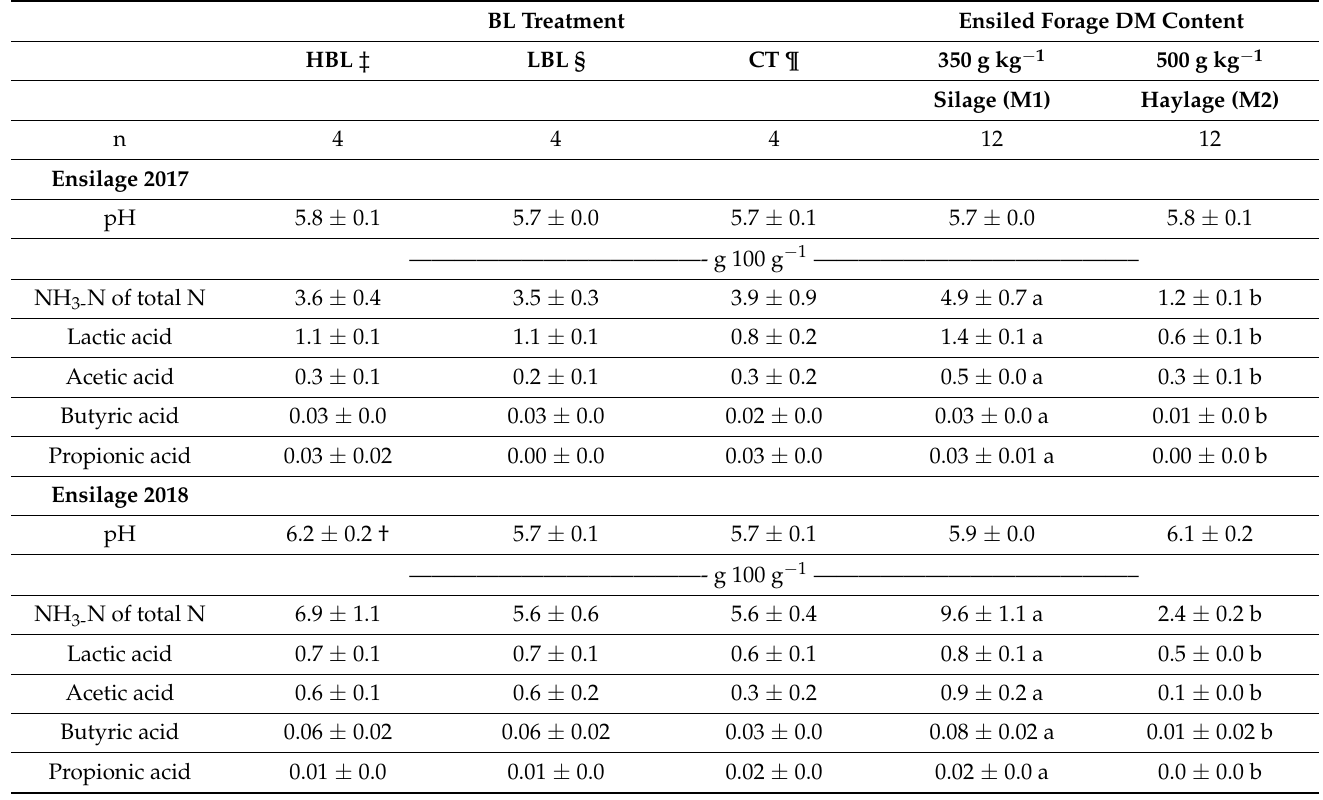
Table 6. Post-ensiled nutritive value of second cut alfalfa forage and characteristics of ensiled products of BL treatments and forage DM